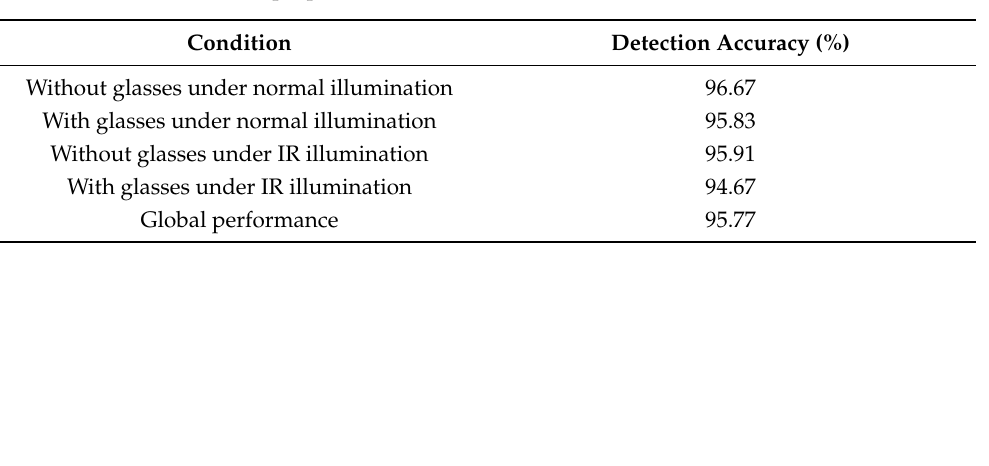
Table 5. Performance of the proposed S-CNN under four different